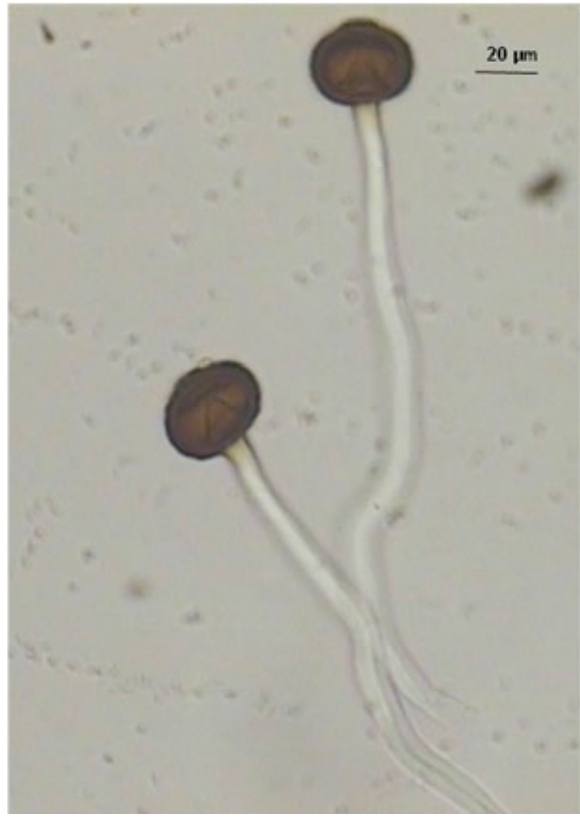
Figure 1. Teliospores (×200) of Pileolaria terebinthi